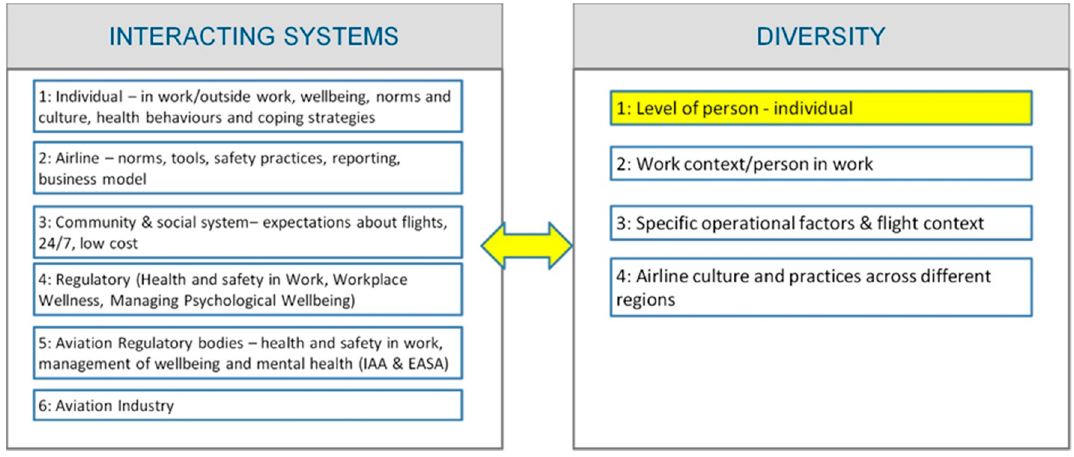
Figure 6 . Framing Problem—six systems and COVID scenarios . Figure 6. Framing Problem—six systems and COVID